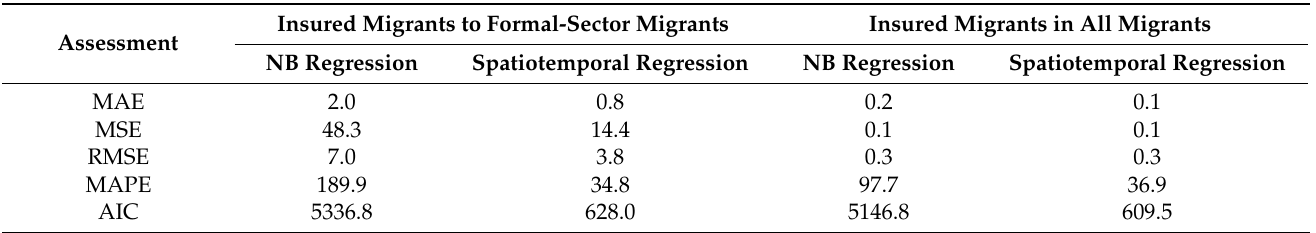
Figure 6. Kernel density plot of the ratio of insured migrants to all migrants from NB regression and spatiotemporal model and the actual data. Table 5. Assessment of the model fitness for NB regression and the spatiotemporal